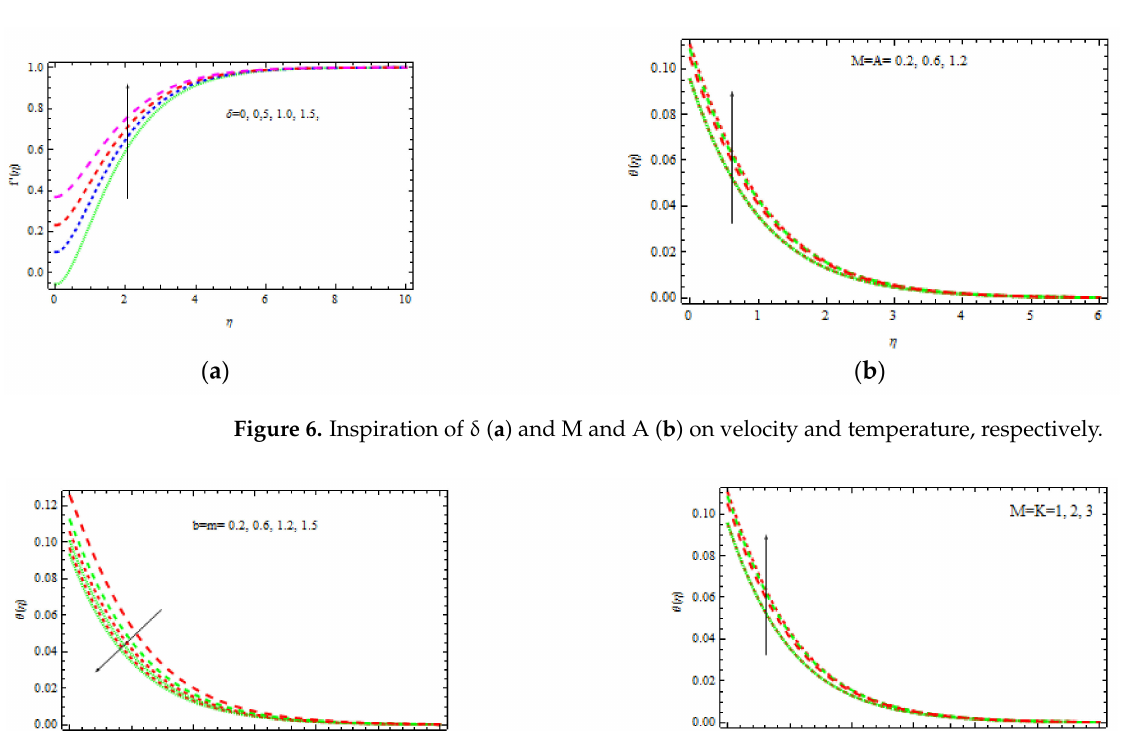
Figure 5. Inspiration of N ( a ) and L ( b ) on velocity.